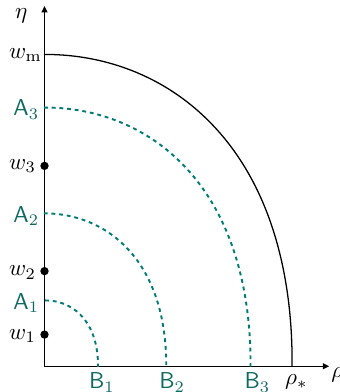
Figure 11. The 4-cycles of type C are obtained combining the dashed arcs A a B a with the S 2 and the φ circle in the base of the Dz fibration. The 4-cycles of type B are obtained combining a segment [ w ] on the η axis with the S 2 and the Dz circle a , w a +1